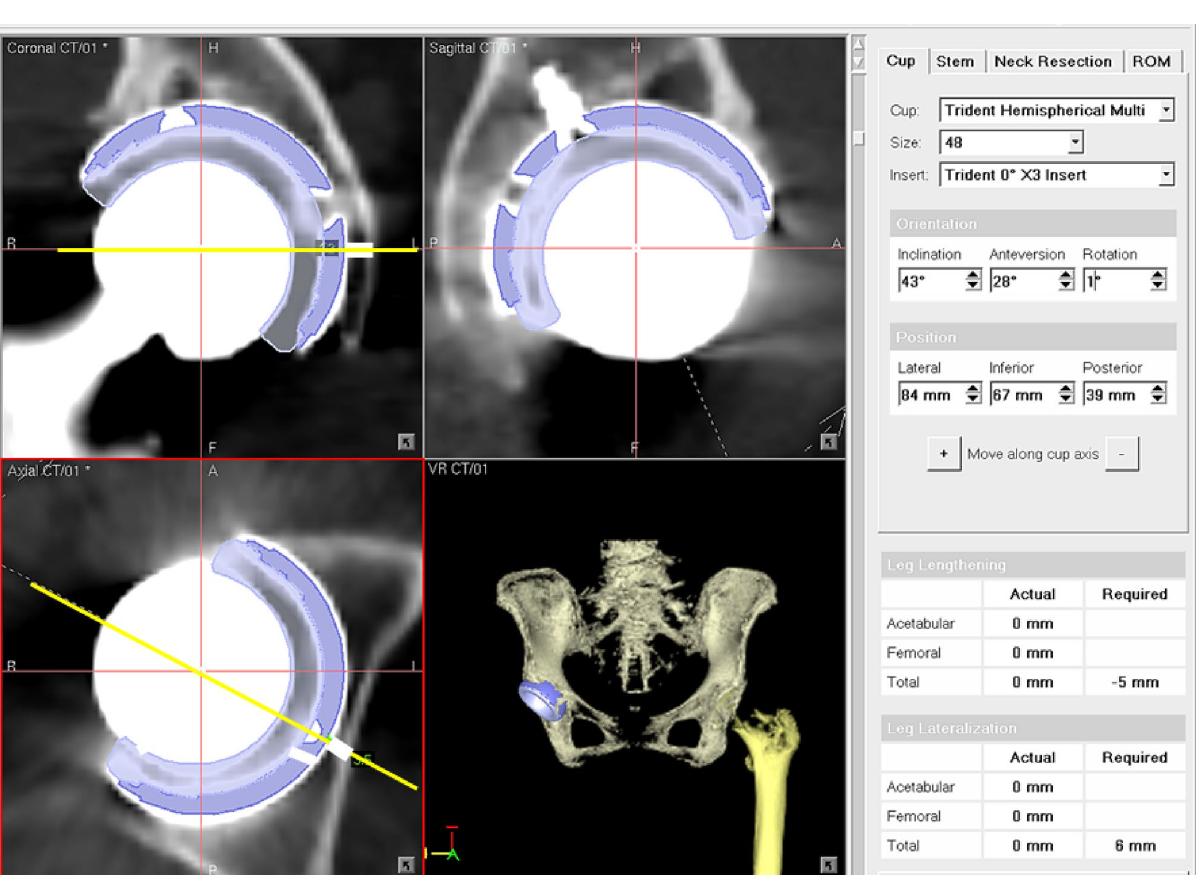
Figure 3. Postoperative cup positions are measured on the OrthoMap 3D Navigation System workstation. White lines indicate the distance between the outer edge of the cup and the medial edge of the acetabulum in axial and coronal